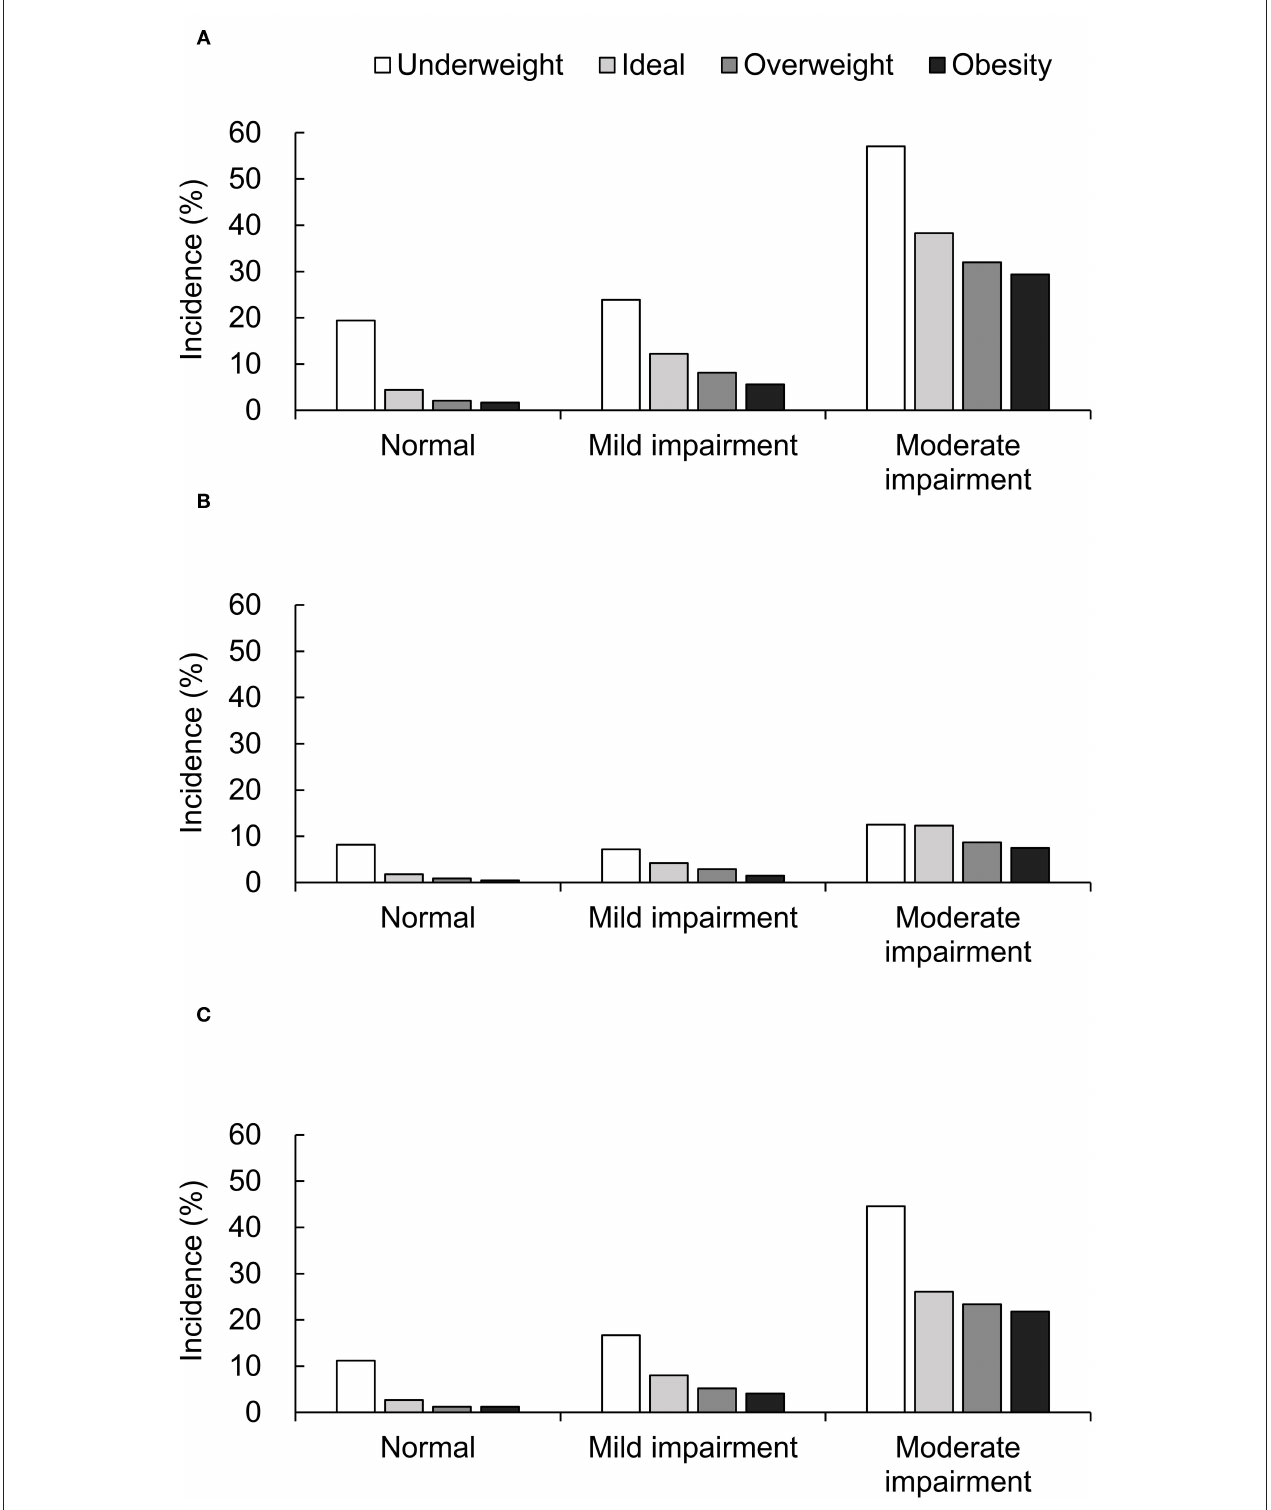
FIGURE 1 | Mortality rate of all-cause (A) , cardiac (B) , and non-cardiac death (C) based on BMI and renal function categories.